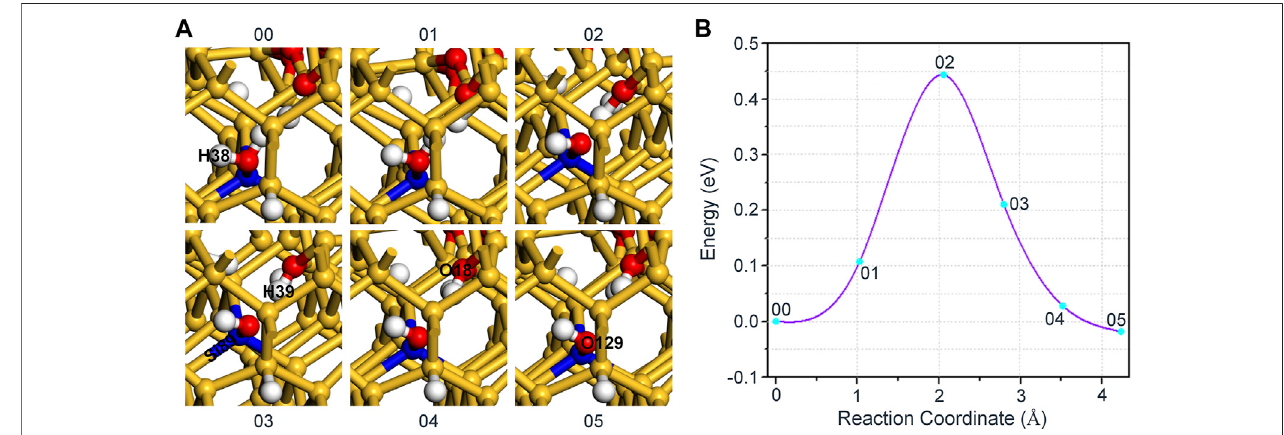
FIGURE4|(A) Theschematicdiagramofthereactionbetween P b0 defectandH 2 O.H 2 Ointheinitialstate00takestheformconnectedwithSi89insteadofthefree form. (B) The variation of the energy with different reaction coordinates for the reaction of H 2 O and P b0 defect.